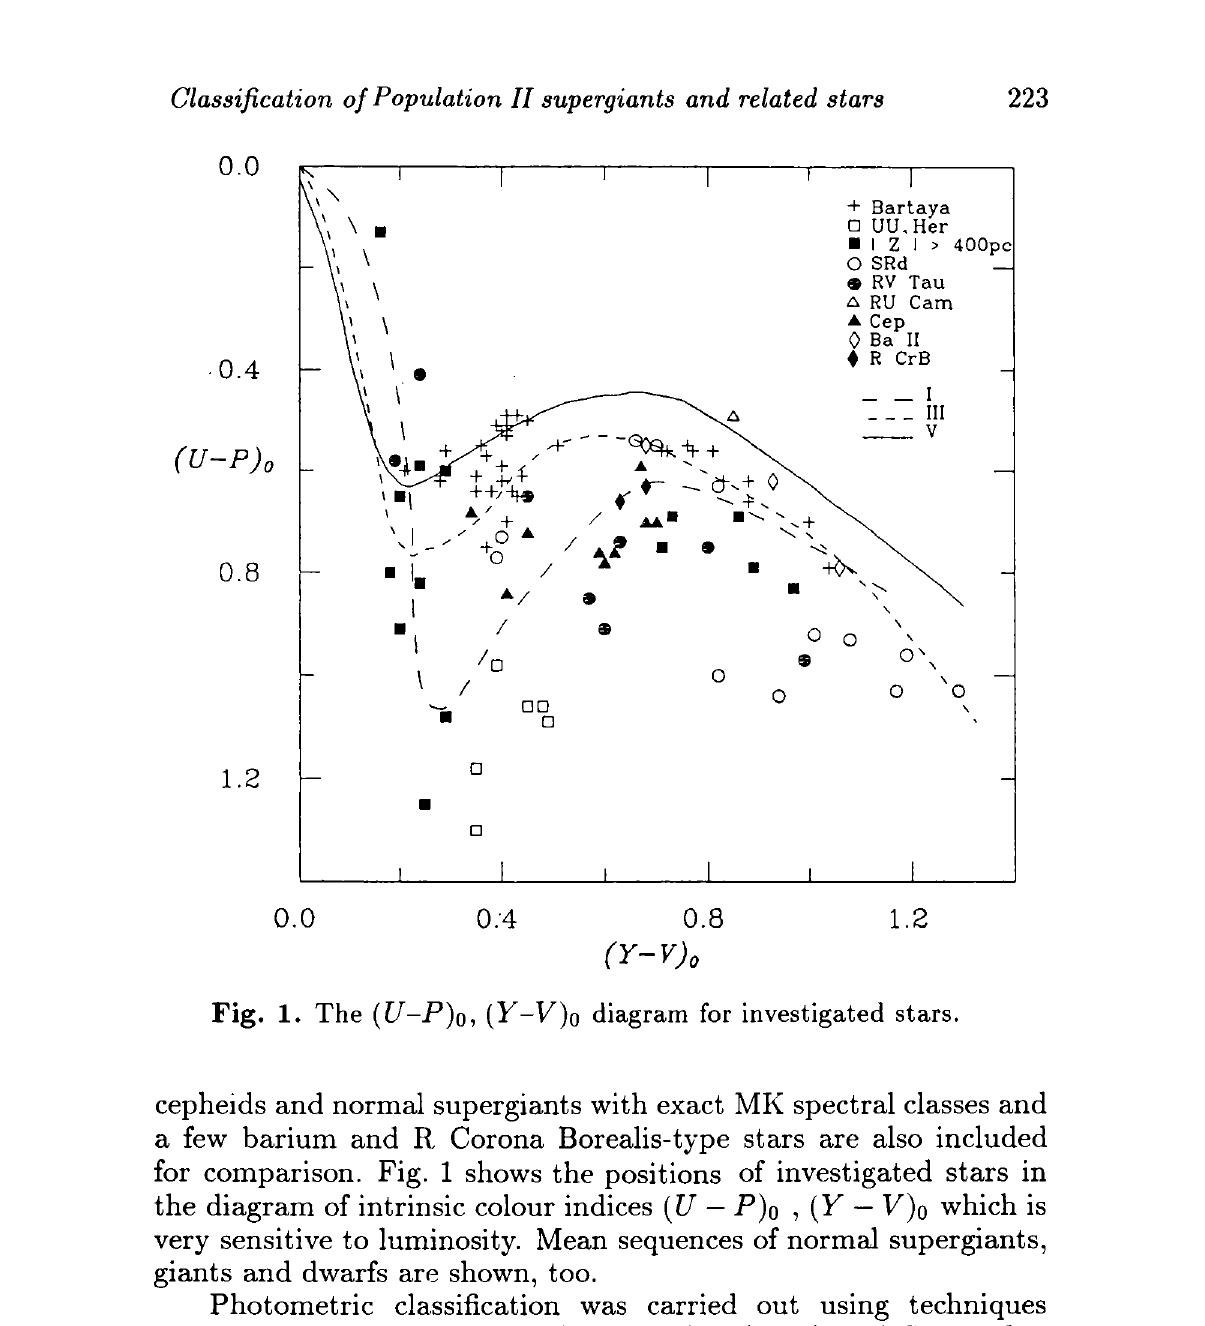
Fig. 1. The (U-P) o, (K-V^o diagram for investigated